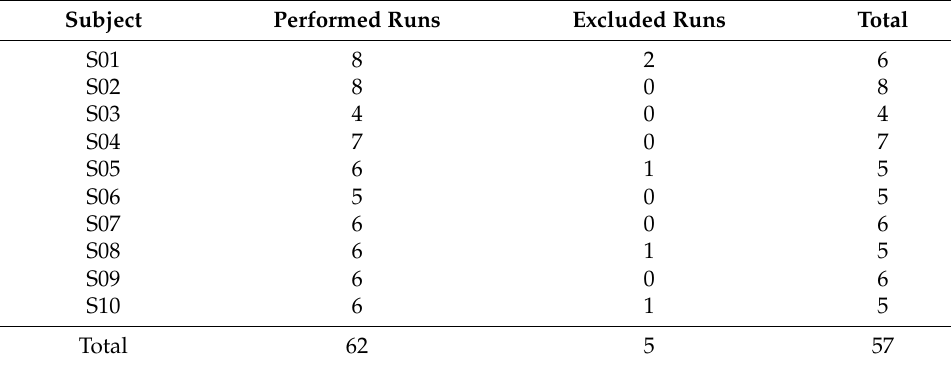
Table 3. Relationship for the runs performed by each